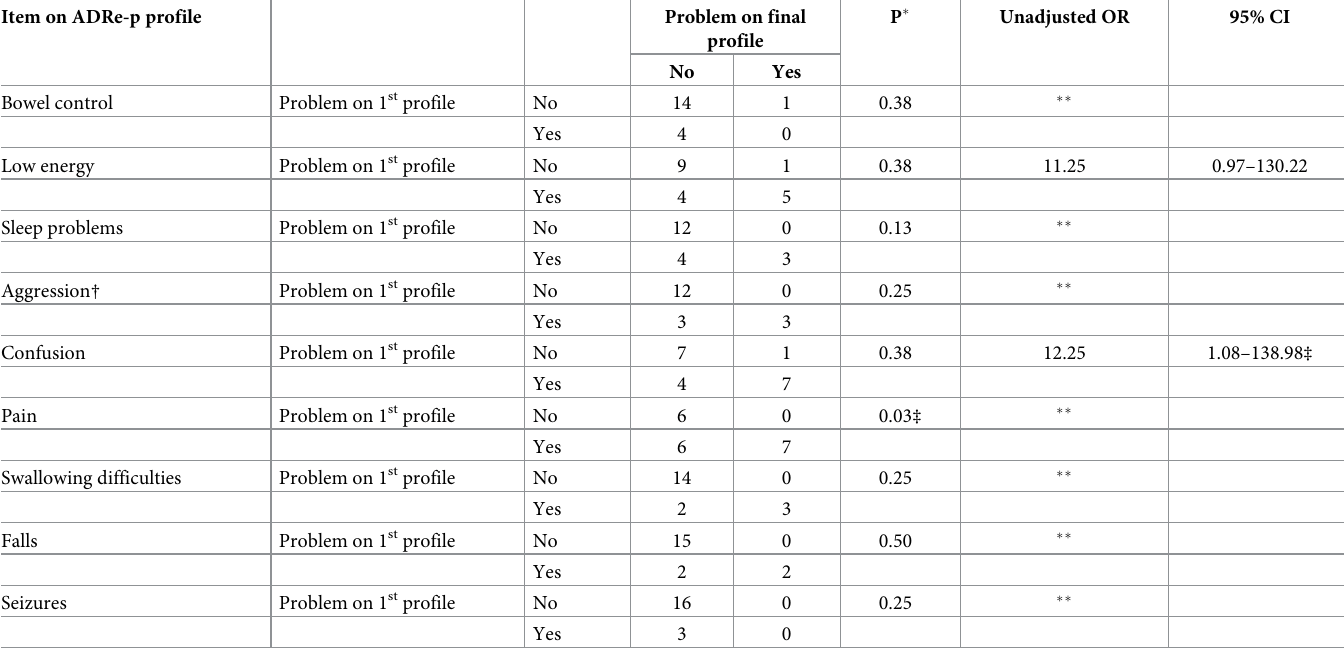
Table 2. ADRe-p Profile items and responses: Observations and questions. Item on ADRe-p